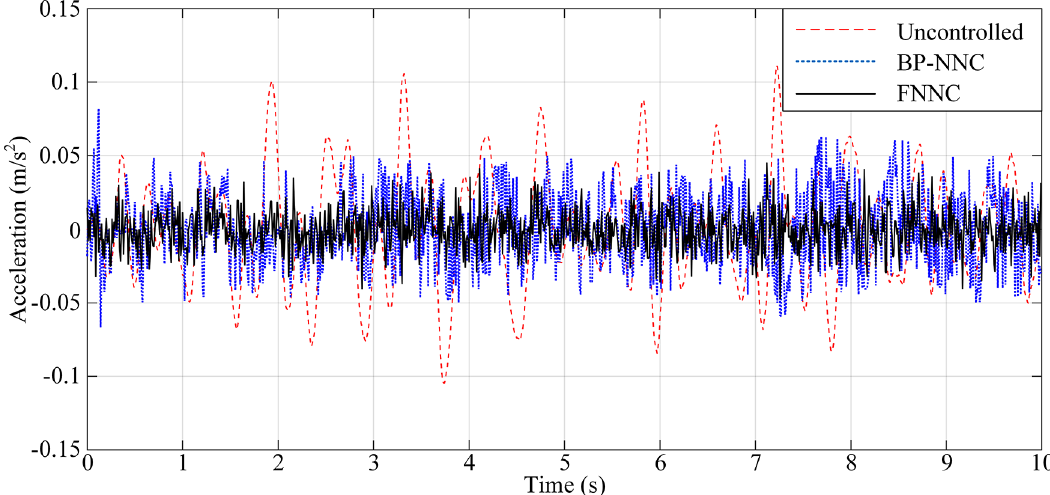
Fig. 19. Time-domain response of horizontal vibration acceleration of the elevator car with no load.